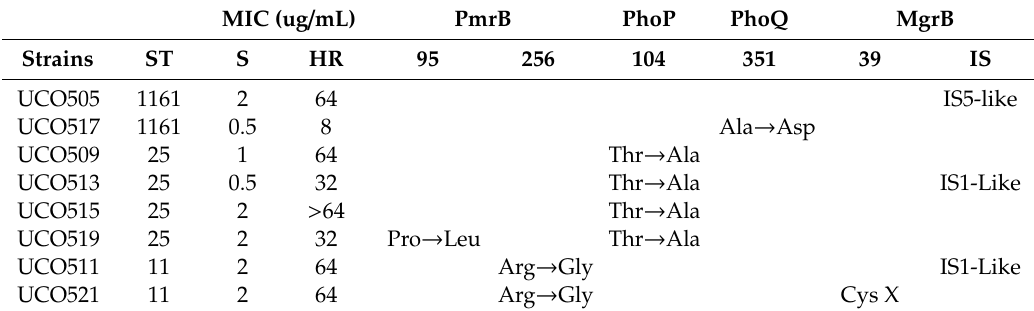
Table 3. Modification of CST-resistance genes in CST-HR-derived K. pneumoniae isolates.